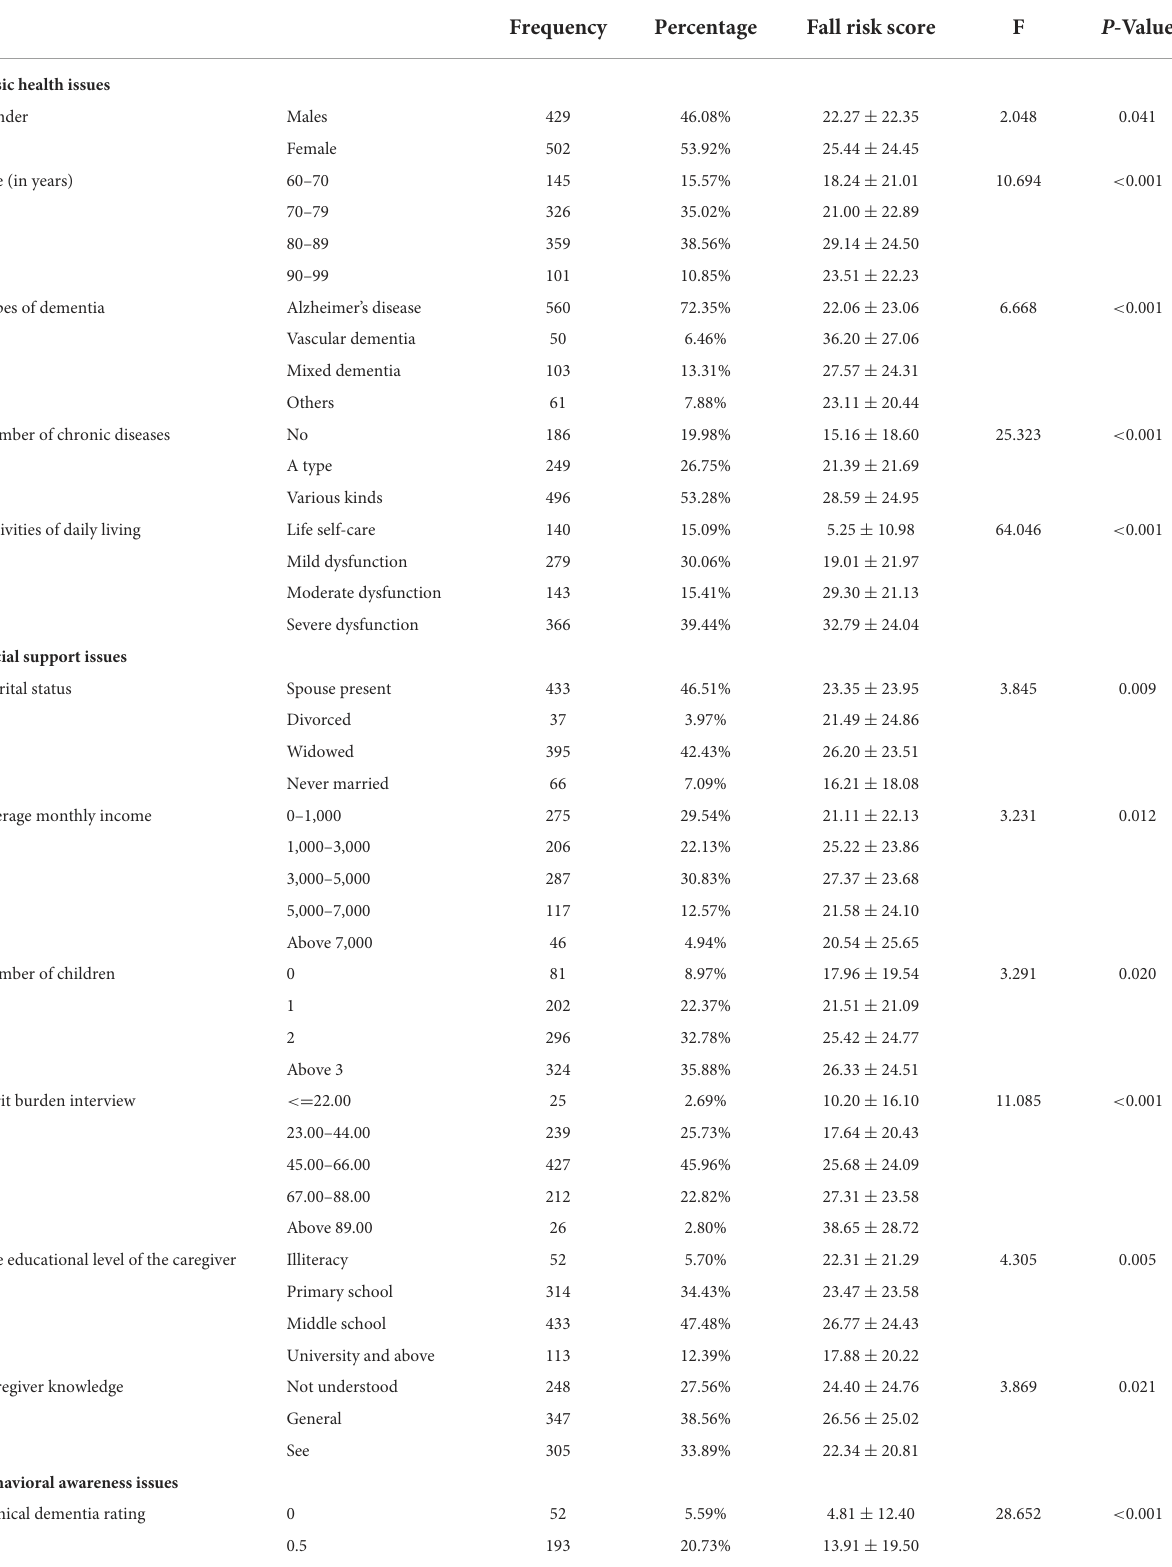
TABLE 2 Basic demographic characteristics and health